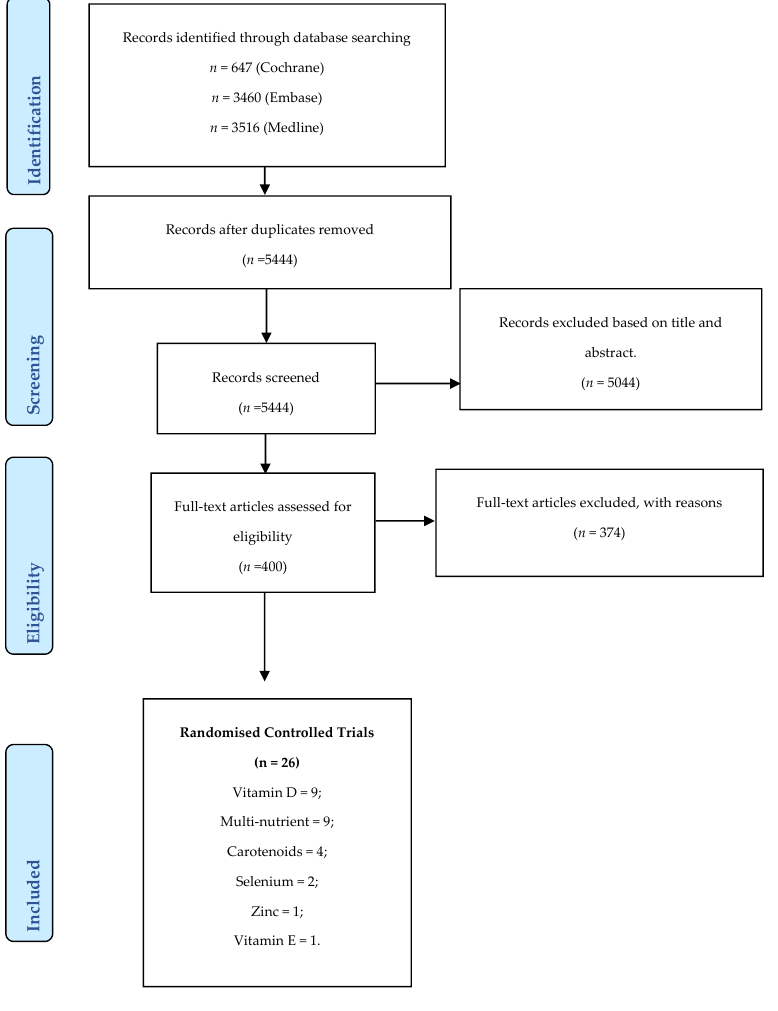
Figure 1. PRISMA Figure 1. PRISMA Flowchart.